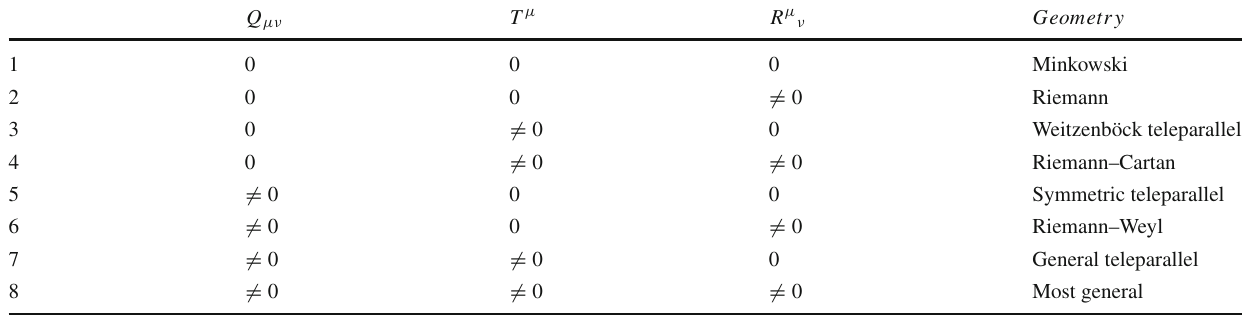
Table 1 Classification of spacetime. In literature, sometimes firstly Q μν is decomposed as Q μν = Q μν + 1 g μν Q μν = 0, then the case of Q μν = 0 and Q (cid:2)= 0 is called Weyl geometry. But, here by “Weyl geometry” we mean Q μν (cid:2)= 0 in